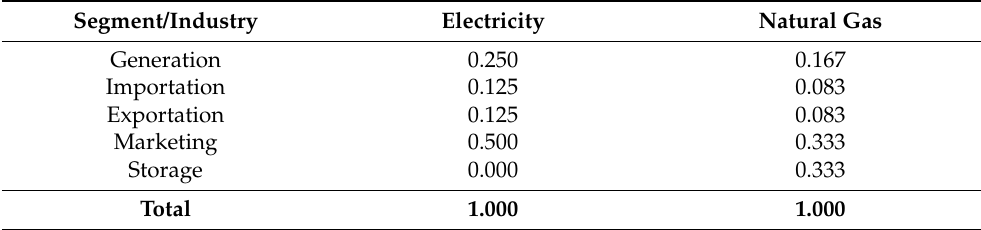
Table 3. Weights for calculating PMR indicators. Source: